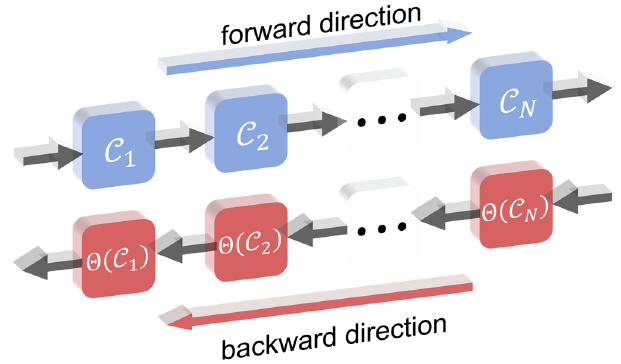
Fig. 2 The order-reversing condition. If a system experiences a sequence of processes C 1 ; ¼ ; C N in the forward-time representation (in blue), then the system should experience the opposite sequence Θ ð C N Þ ; ¼ ; Θ ð C 1 Þ in the backward-time representation